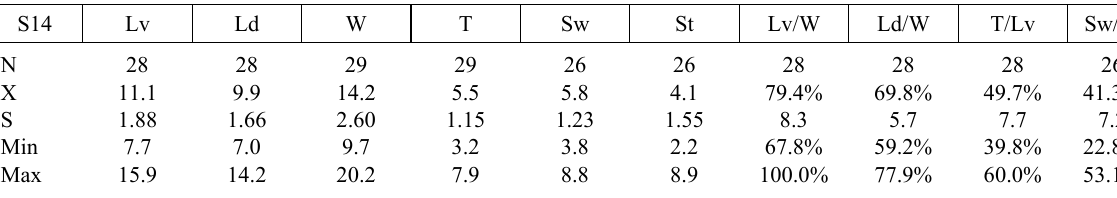
Figure 6K(cid:150)M Material . NMW 2011.11G.372 (Ld = 12.7, W = 13.7, T = 6.7, Sw = 7.6), articulated shell; sample S14, Derenjal Mountains.